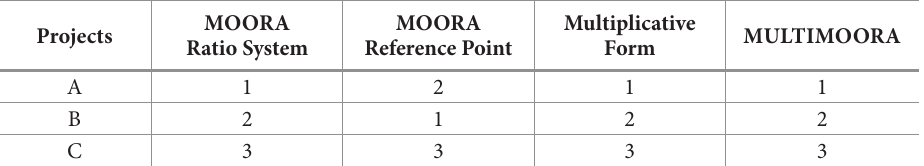
Table 1. The reaction of the projects on the objectives after the MULTIMOORA approach